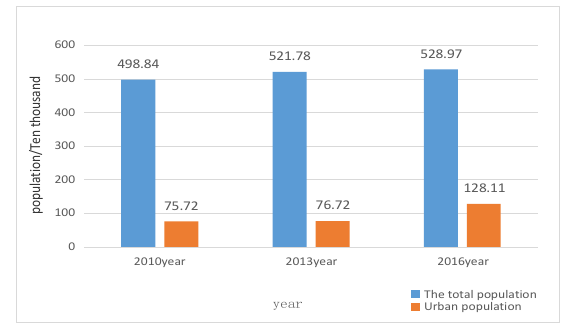
Figure 4-6 total population and urban population of Guilin in 2010, 2013 and